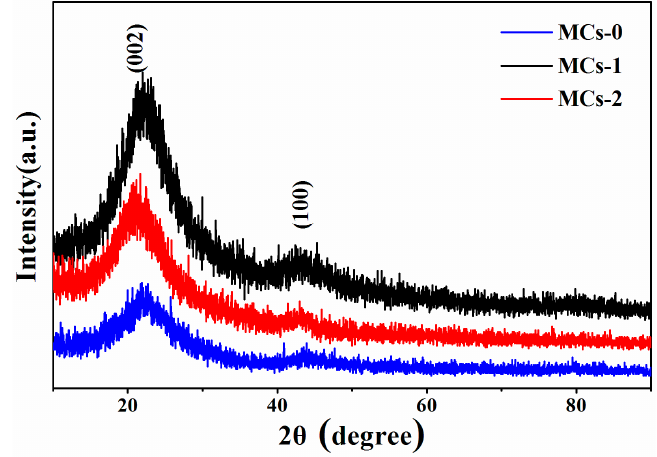
Figure 3. X-ray diffraction (XRD) patterns of MCs-0, MCs-1, and MCs-2.